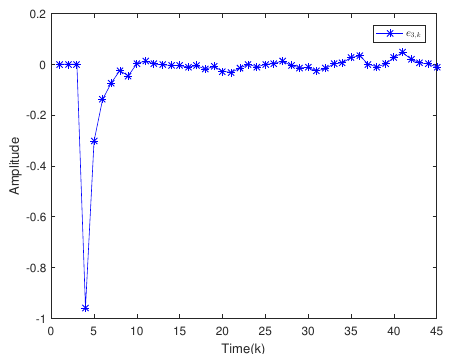
Figure 7. Filtering error e 3, k under the RAP